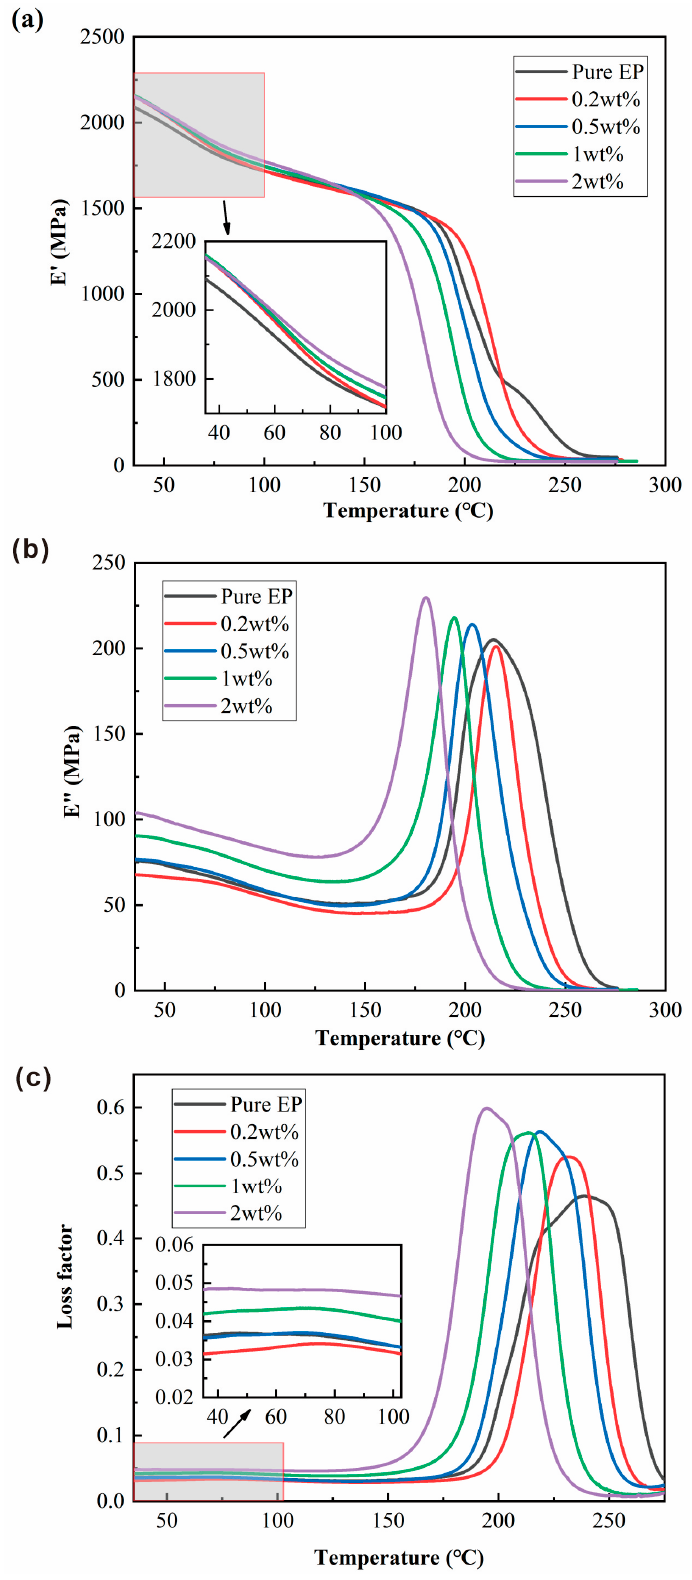
Figure 9. ( a ) Storage modulus, ( b ) loss modulus, and ( c ) loss factor of the BPEI-ZIF-8/IL/EP composites with different addition levels (wt%) of nano fl uid.